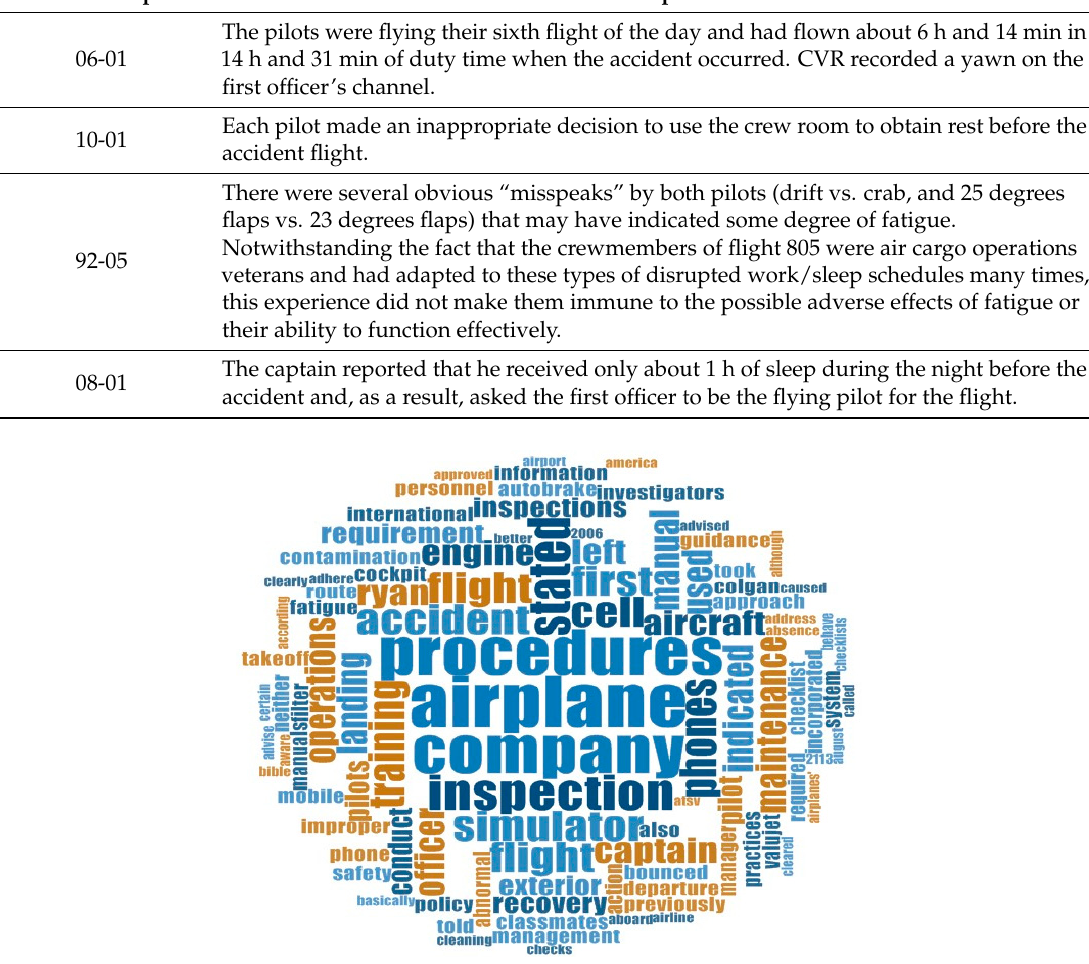
Figure 10. Tag cloud for airline management contributing factors.